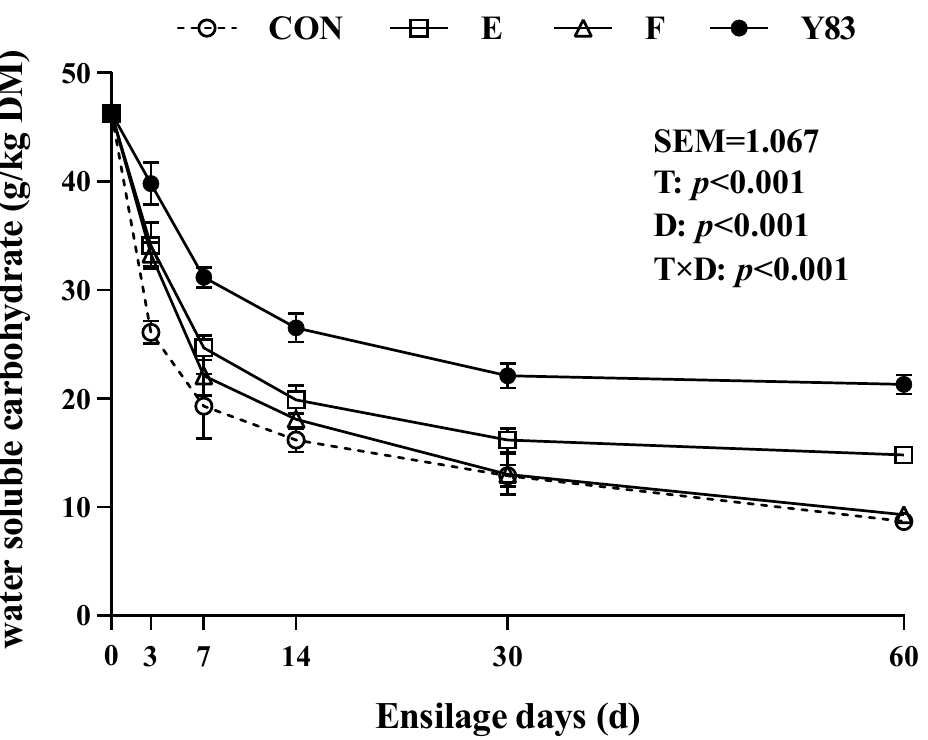
Figure 1. Effect of additives on water soluble carbohydrate (WSC) contents of rice straw silages during ensiling. Abbreviations: CON, control; E, fibrolytic enzyme; F, Trichoderma reesei ; Y83, Enter- ococcus faecium Y83; T, treatments; D, ensiling days; and T×D, the interaction between treatments and ensiling days ( p < 0.05).